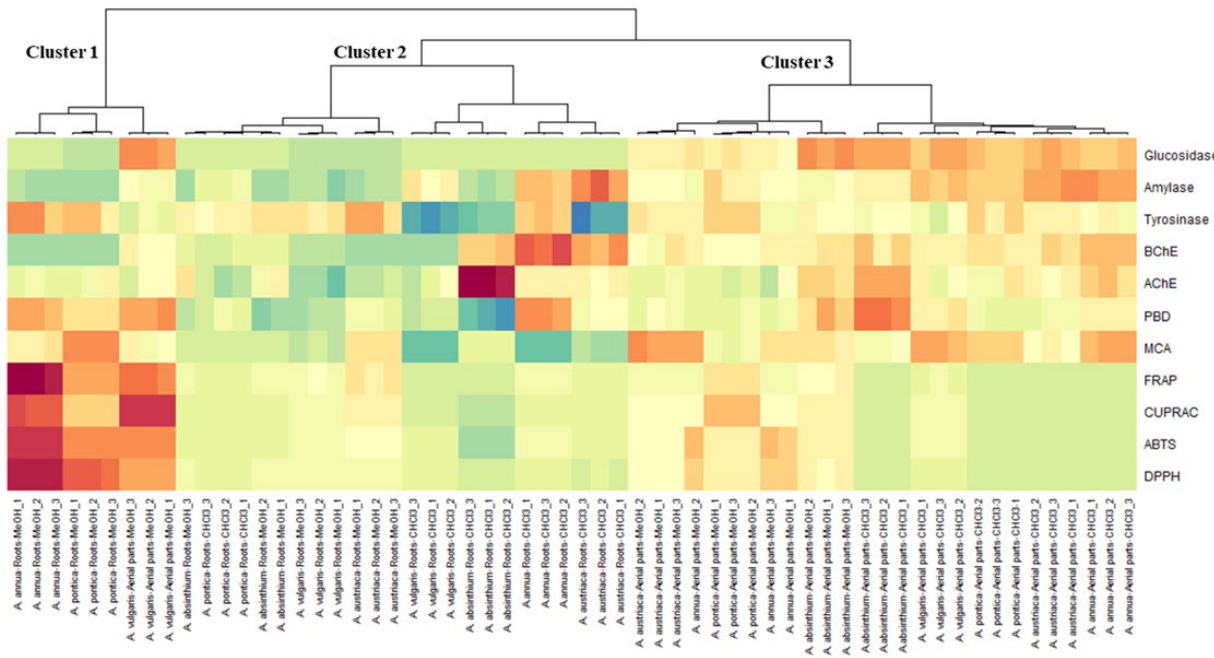
Figure 3. Clustered image map (red color: high bioactivity; blue color: low bioactivity) based on the biological activities dataset.